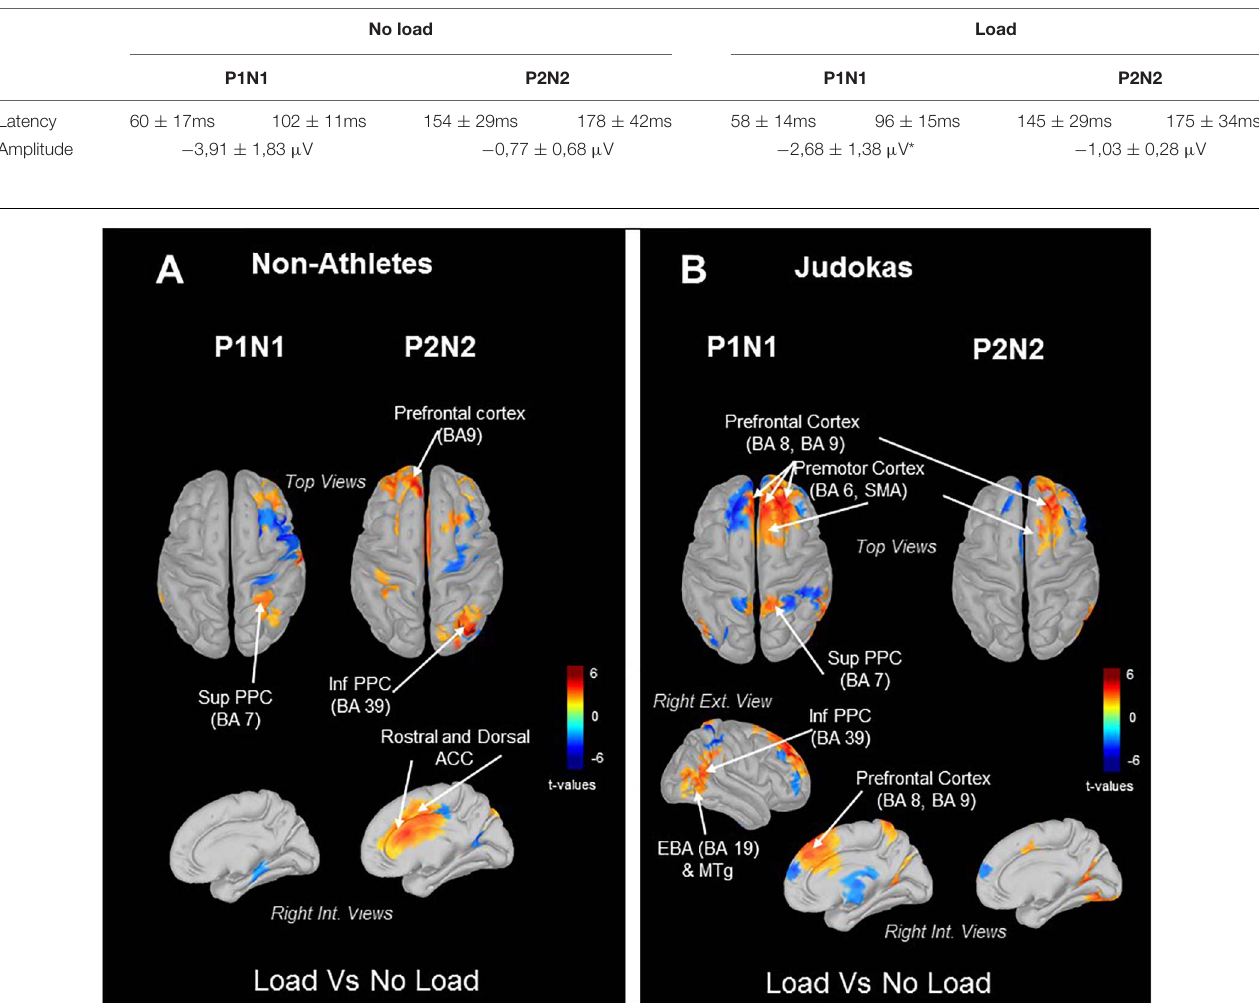
FIGURE 3 | Topographic maps (dSPM) computed from all trials. Significant t- values ( p ≤ 0.05, n = 14) of the source localization (Loaded minus Control condition) were shown at different timing to assess the dynamic of these activities during the Early SEP and Late SEP. Panel (A) in Judokas and panel (B) in Non-Athletes.